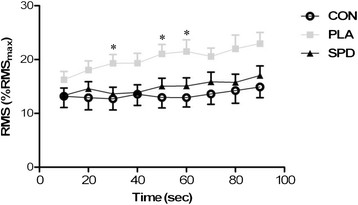
Time course of root mean square (RMS) values (expressed as a percentage of the maximal RMS of the best MVC trial) of thetriceps brachiimuscle (lateral head) throughout the 90-sec time trial. Results are expressed as mean values ± SD in the three conditions (CON, PLA and SPD). Two-way ANOVA was used (time and condition); time effect: p < 0.001, condition x time effect: p = 0.0167. Bonferroni post hoc analysis showed significant difference between PLA and SPD for time 30-, 50- and 60-sec (p < 0.05). Tendencies were observed for time 40-sec (p = 0.07), 80-sec (p = 0.08) and 90-sec (p = 0.07).